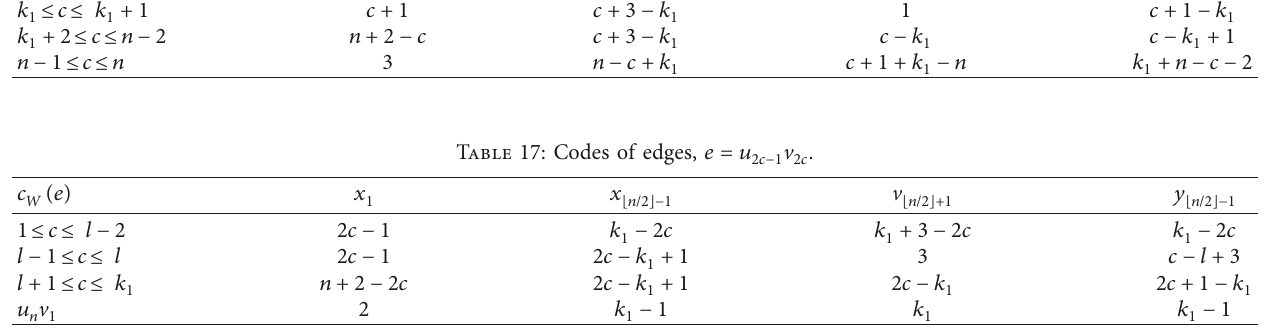
Table 18: Codes of edges, e � u